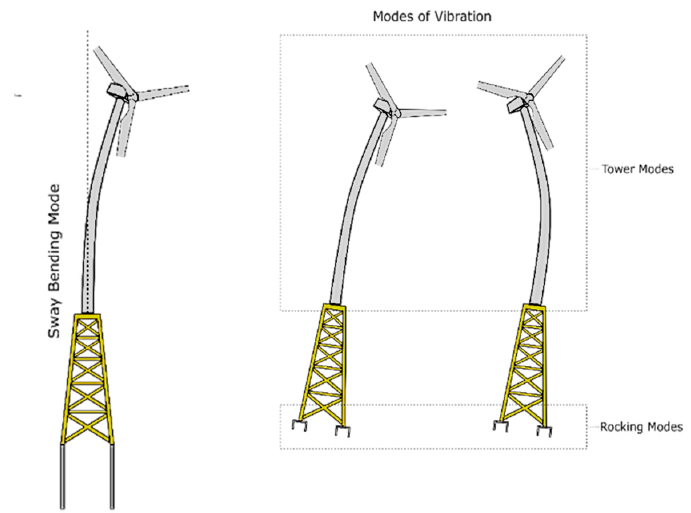
Figure 3. Vibration modes in different foundation systems.